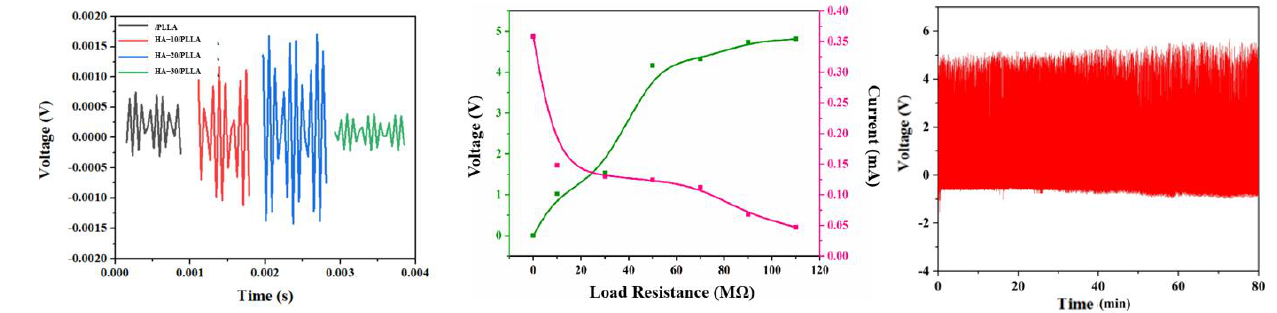
Figure 5. The output performances and durability of PLLA and HA/PLLA PENG.